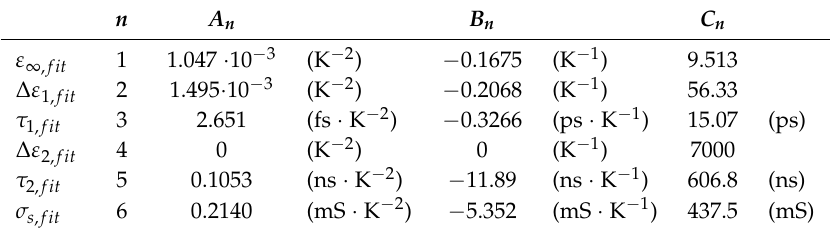
Table 2. Temperature coefficients of the second order polynomial fit to the temperature dependent Cole-Cole parameters of